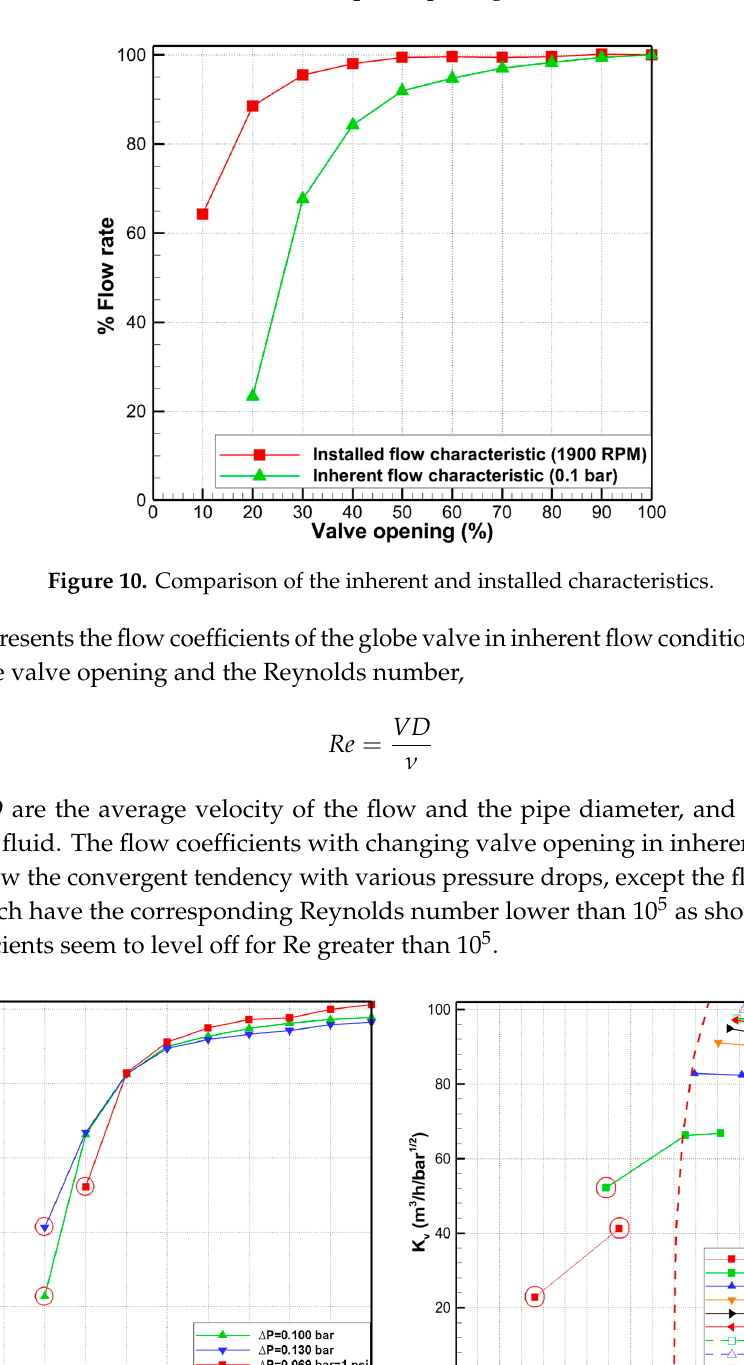
Figure 11. Flow coefficient in inherent condition: ( a ) with respect to valve opening; ( b ) with respect to the Reynolds number.